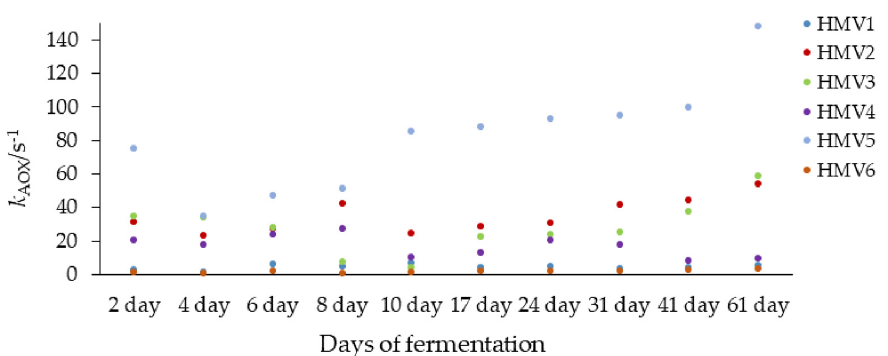
Figure 7. Antioxidant capacity constant (s − 1 ) of homemade fruit vinegars (HMV) over time